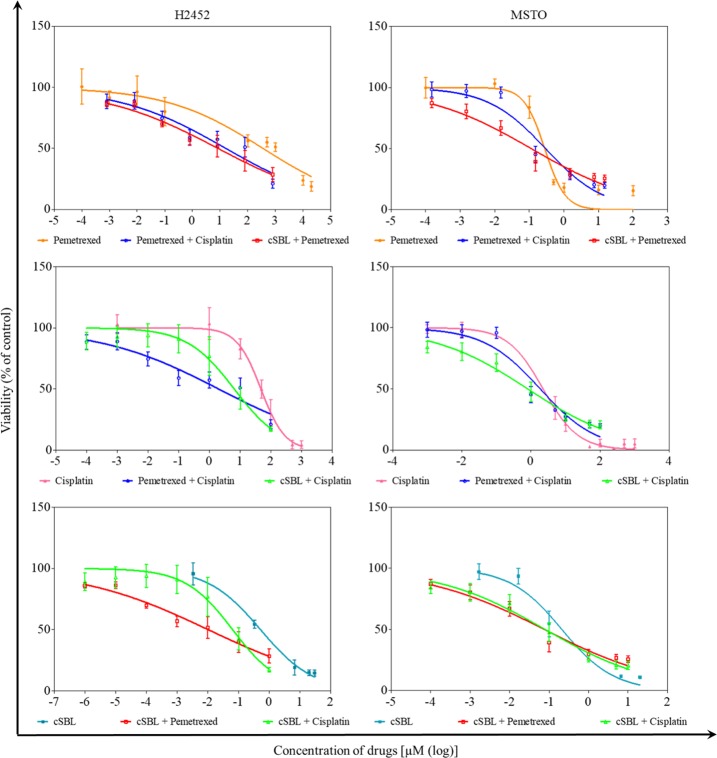
Viability curves of H2452 and MSTO cells treated with pemetrexed, cisplatin, and cSBL, either alone or in combination.Each group of cells was treated with fixed concentration ratios of pemetrexed:cisplatin:cSBL as follows: 800:100:1 (for H2452 cells) or 3:20:2 (for MSTO cells). Each data point represents the mean ± SD of at least three independent WST-8 assays. Each sample was plated in triplicate. The y-axis indicates the viability of cells. The x-axis indicates the concentration of pemetrexed (upper), cisplatin (middle), or cSBL (lower).